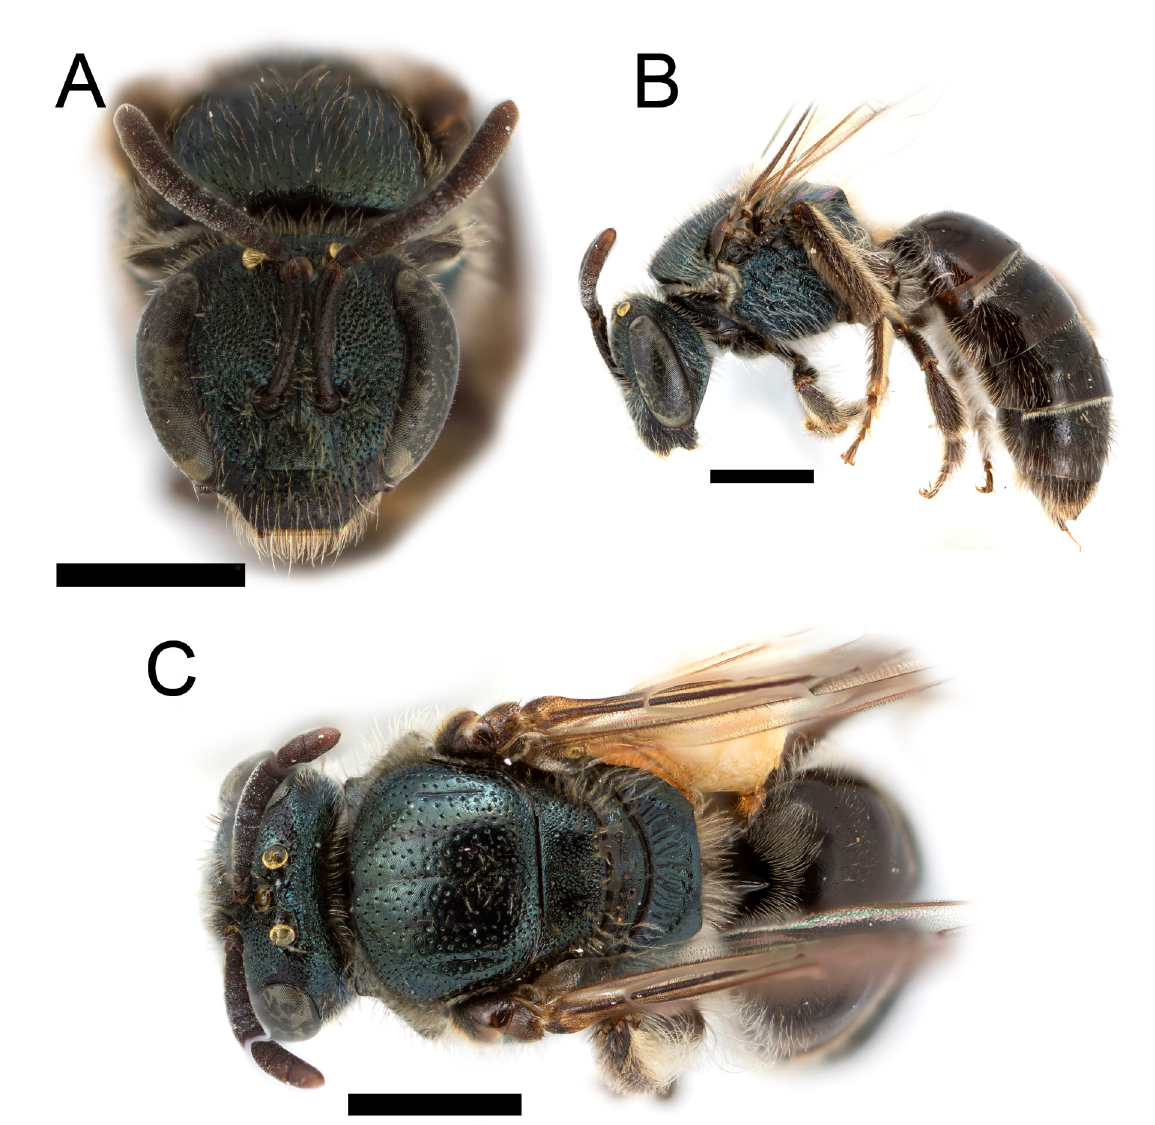
Fig. 18. Lasioglossum genaroi sp. nov., ♀. A . Face. B . Lateral habitus. C . Dorsal habitus. Scale bars = 1